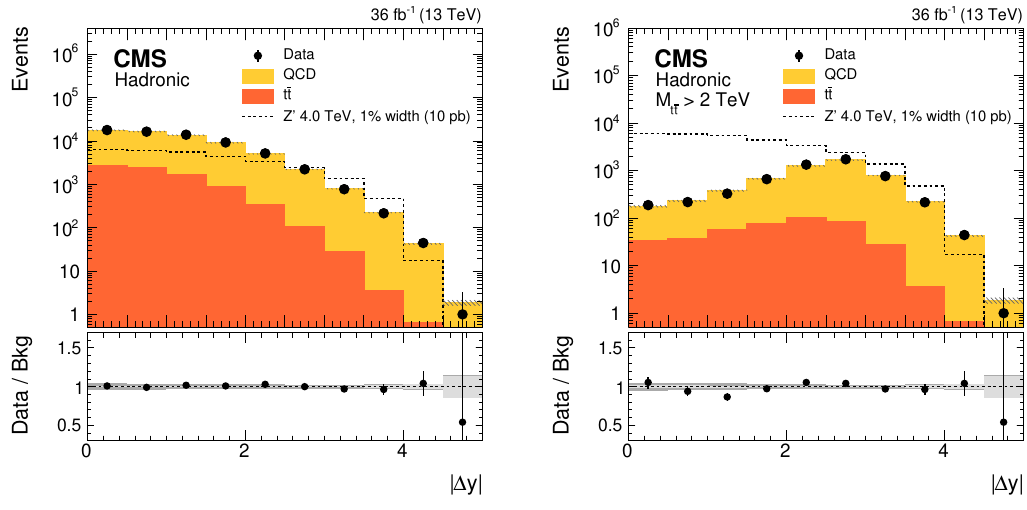
Figure 4 . Dijet rapidity di(cid:11)erence ((cid:1) y ) for events passing the fully hadronic event selection for all m (left) and for events with an m > 2 TeV (right). The contribution expected from a 4 TeV tt tt Z 0 boson, with a relative width of 1%, is shown normalized to a cross section of 10 pb. The hatched band around the simulated distribution represents the statistical and systematic uncertainties. The lower panels in each plot show the ratio of data to the SM background prediction and the light (dark) gray band represents statistical (systematic)